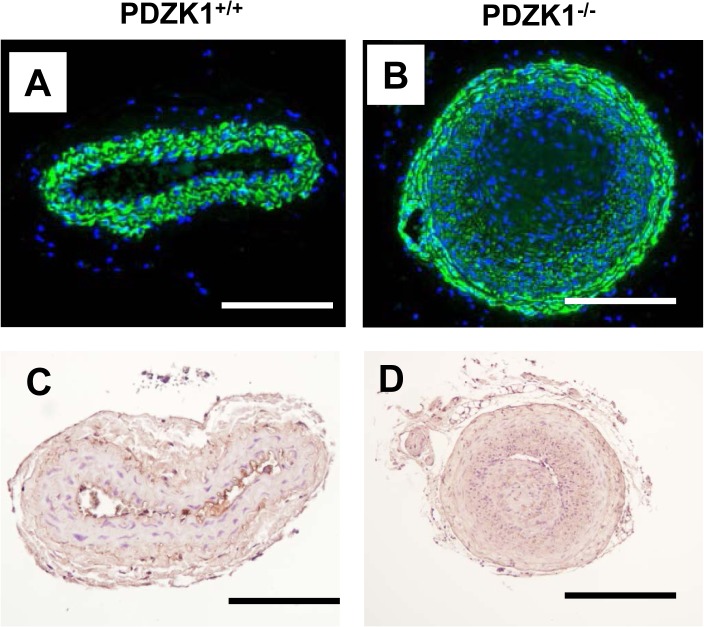
VSM cells populate the neointima that develops in PDZK1-/- mice.Male wild-type PDZK1+/+ (A, C) and PDZK1-/- mice (B, D) underwent unilateral left carotid artery ligation for the evaluation of neointima formation. Arteries were harvested 21d later, and immunofluorescent staining was performed with anti-αSMA monoclonal antibody to detect smooth muscle cells (A and B, green fluorescent staining for αSMA and blue for DAPI), and immunohistochemistry was done with anti-F4/80-polyclonal antibody to detect macrophages (C and D). Positive F4/80 signal is seen in rare luminal macrophages in C. The scale bar indicates 100 μm.